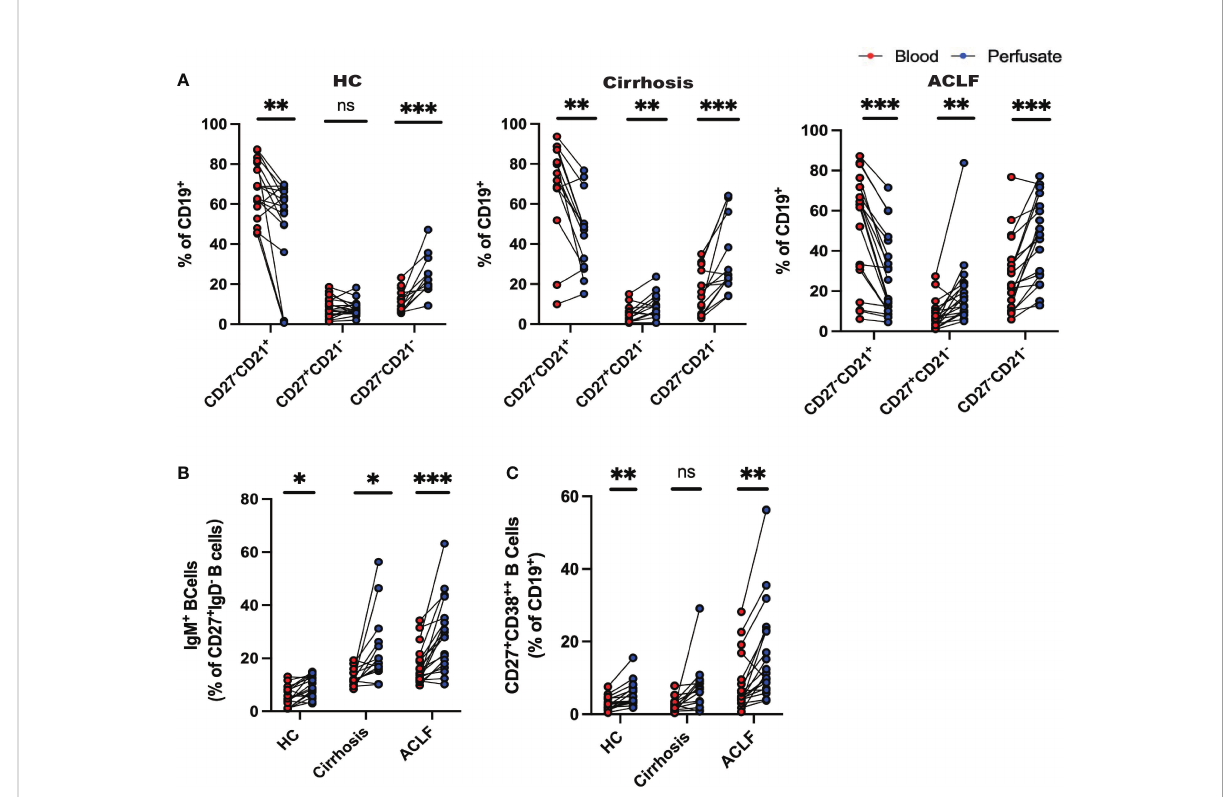
FIGURE 3 Distinct pro fi le of intrahepatic B cells compared with peripheral blood. (A) CD27 − CD21 + CD19 + B cells, CD27 + CD21 − CD19 + B cells, and CD27 − CD21 − CD19 + B cells of liver-in fi ltrating cell subsets in paired blood and perfusate from ACLF, cirrhosis, and HC (HC, n = 17; cirrhosis, n = 14; ACLF, n = 18). (B) CD27 + IgD − IgM + CD19 + B cells of liver-in fi ltrating cell subsets in paired blood and perfusate from ACLF, cirrhosis, and HC (HC, n = 17; cirrhosis, n = 14; ACLF, n = 18). (C) CD27 + CD38 ++ CD19 + B cells of liver-in fi ltrating cell subsets in paired blood and perfusate from ACLF, cirrhosis, and HC (HC, n = 17; cirrhosis, n = 14; ACLF, n = 18). *p < 0.05, **p < 0.01, and ***p < 0.001; ns, not signi fi